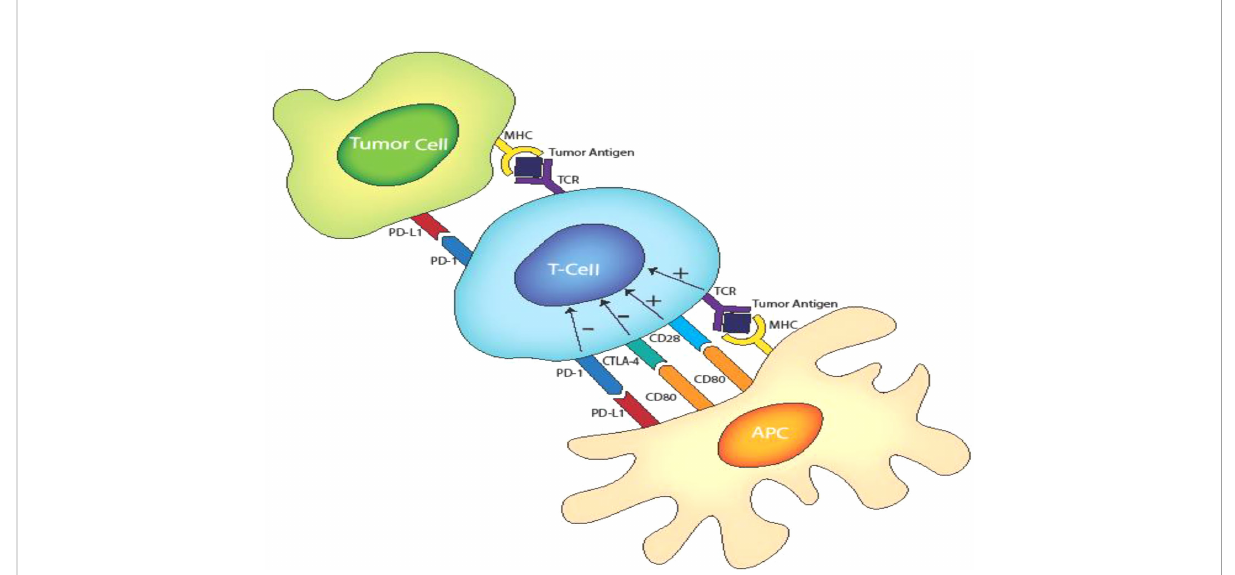
FIGURE 1 T cell activation and inhibitory receptors-ligand interactions involving TCR/MHC class II. CD28/D80. CTLA-4/CD80 and